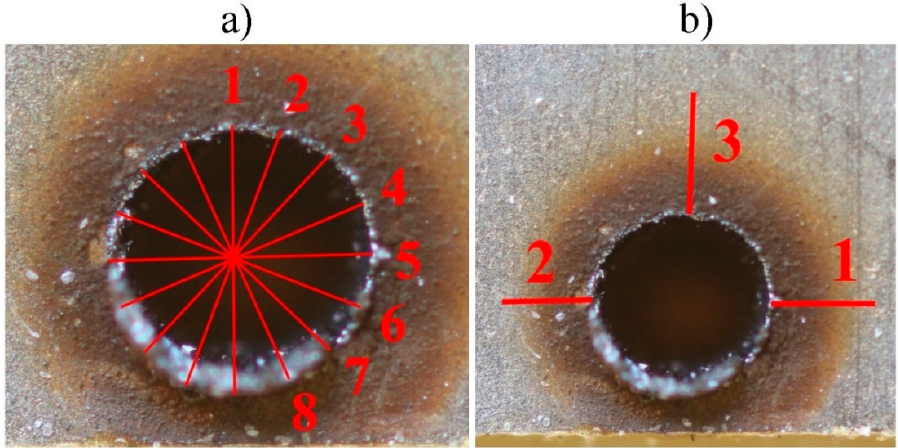
Figure 4. Images showing where the measurements were taken. ( a ) Eight measurements for the hole diameter. ( b ) Three measurements for the burning effect (BE) width.